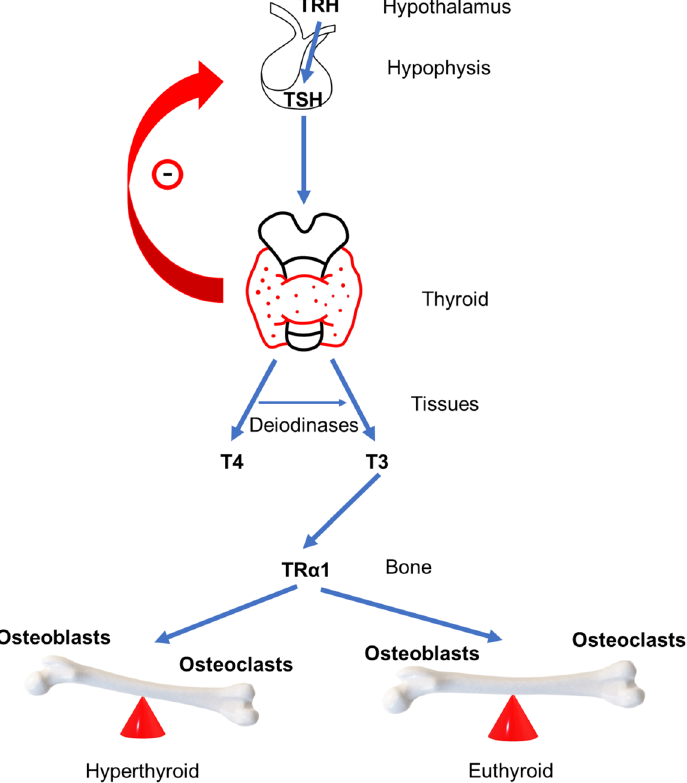
Figure 1. Schematic representation of the hypothalamus–pituitary–thyroid axis and effect on bone in hyperthyroidism and euthyroidism, TRH thyroid releasing hormone, TSH thyroid stimulating hormone, T4 thyroxine, T3 three iodothyronine, and TR α 1 thyroid hormone receptor α .